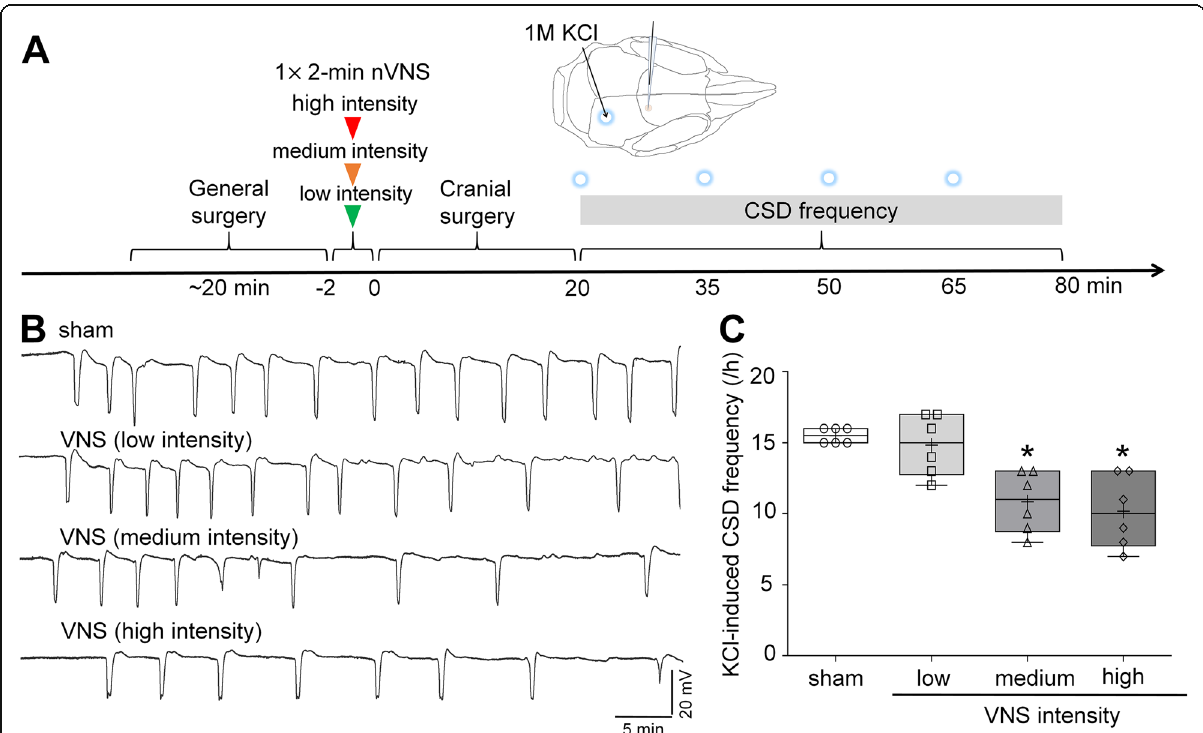
Fig. 1 nVNS intensity-dependently suppresses KCl-evoked CSD frequency. A Schematic diagram of amplitude-response paradigm of acute nVNS. B Representative intra-cortical microelectrode recordings show the effect of sham stimulation or noninvasive transcutaneous VNS at low (1 V for 2 min), medium (11.4 V for 2 min), high intensity (24.4 V for 2 min) on KCl (1 M)-evoked CSD frequency in rats. C Whisker – box plots show that medium and high intensity VNS but not low voltage VNS or sham control inhibit KCl-evoked CSD frequency in rats ( n =6 per group) (whisker: full range; line: median; cross: mean; * P =0.0349 for medium intensity, * P = 0.0149 for high intensity, compared to sham group, Kruskal-Wallis